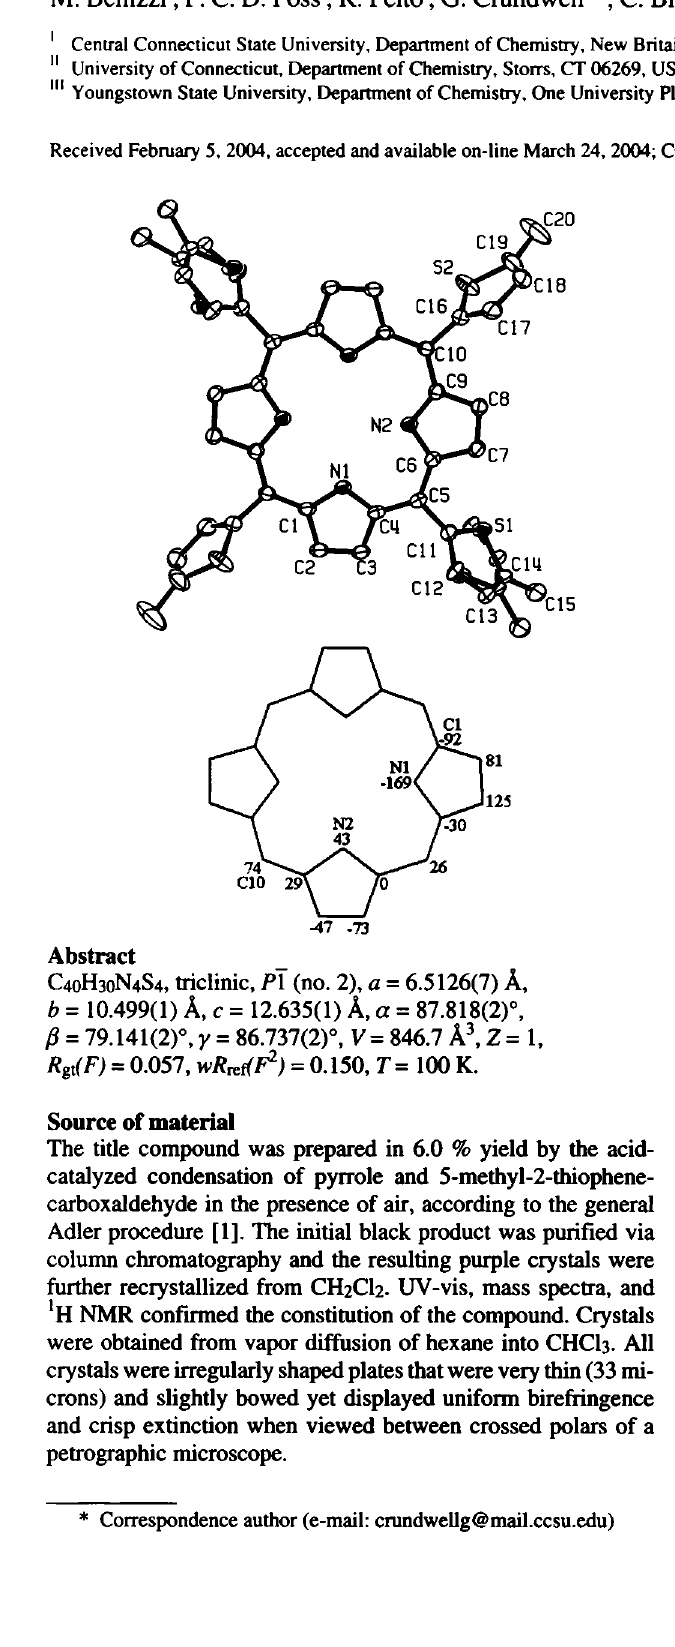
figure, bottom: deviations from mean plane in units of 0.001 A,